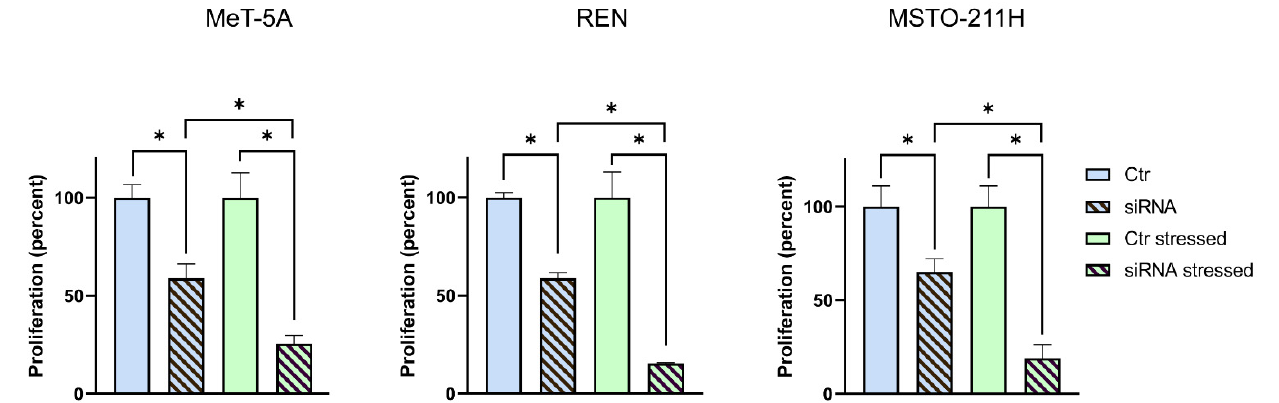
Figure 10. Effect of oxidative stress on cell proliferation of MeT-5A, REN, and MSTO-211H cells silenced for aquaporin-6 (siRNA) and mock-transfected (Ctr). Cell growth was evaluated by measuring the OD at 570 nm at 48 h after cell silencing compared with mock-transfected control cells. Oxidative stress was produced in siRNA and mock-transfected cells, as indicated in Materials and Methods. Values (expressed as the percent of proliferation) are means ± SEM of cells for each of 4 different experiments. *, p < 0.05 (ANOVA, followed by Newman–Keuls’s Q